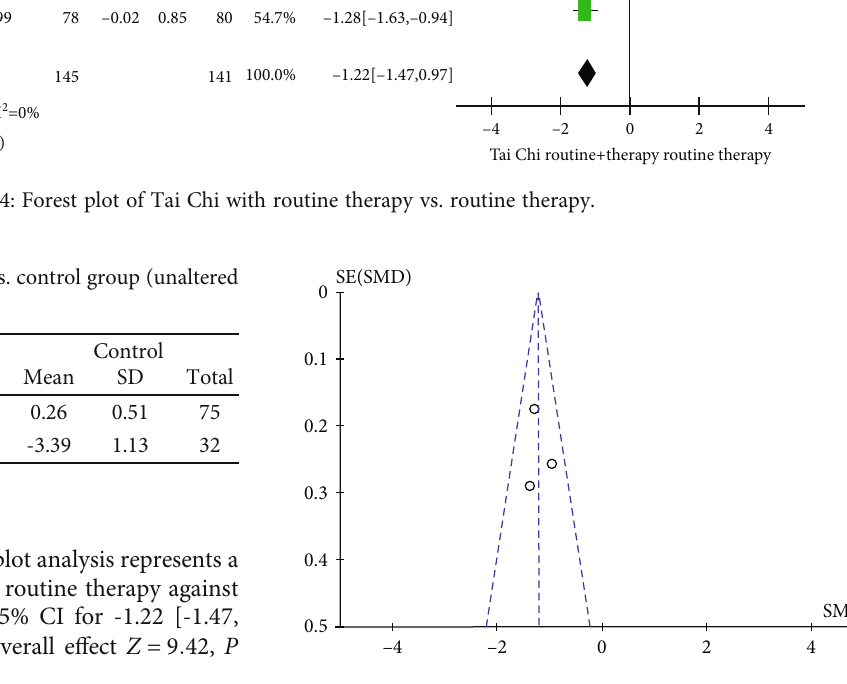
Figure 5: Funnel plot of Tai Chi with routine therapy vs. routine